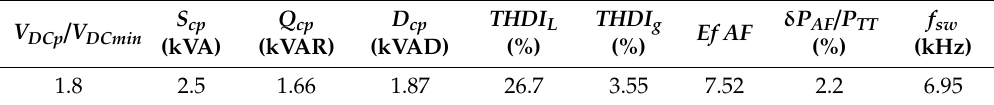
Table 1. The main energetic performances of the adaptive control, at nominal